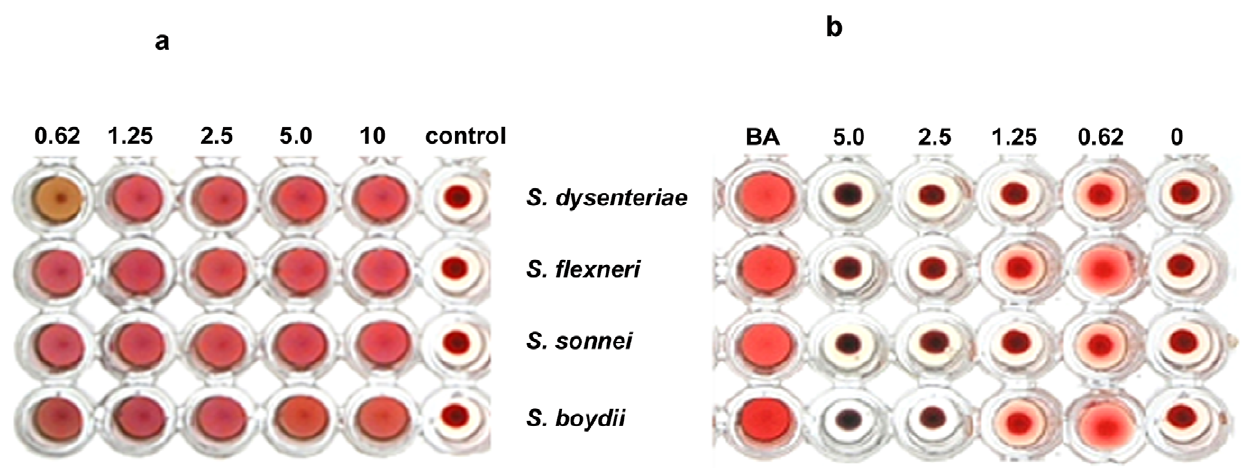
Figure 6. Bacterial hemagglutination and its inhibition by lectin. (a). Hemagglutinating activity of all the four Shigella species was found to be 5 6 10 6 (b).AMFL inhibited this hemagglutinating activity of all the four Shigella species at different concentrations. Minimum concentration of lectin required for inhibition of hemagglutinating activity was found to be 0.625 m g for Shigella dysenteriae and Shigella sonnei, whereas hemagglutinating activity of Shigella flexneri and Shigella boydii were inhibited at 1.25 m g of AMFL.